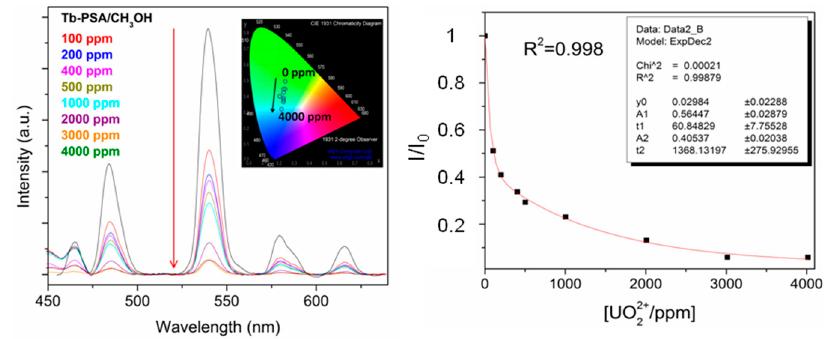
Figure 9 . Left: Emission spectra and Comission Internationale de l´Éclairage (CIE x,y) chromaticities of Tb-PSA from 0 to 4000 ppm of [UO 2 ] 2+ (inset). Right: Relative intensity (I/I 0 ) of the Tb 3+ hypersensitive transition.